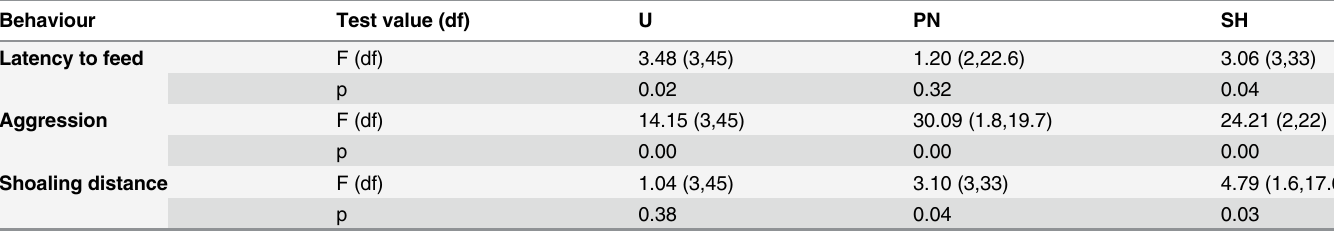
Table 2. Repeated measures ANOVA